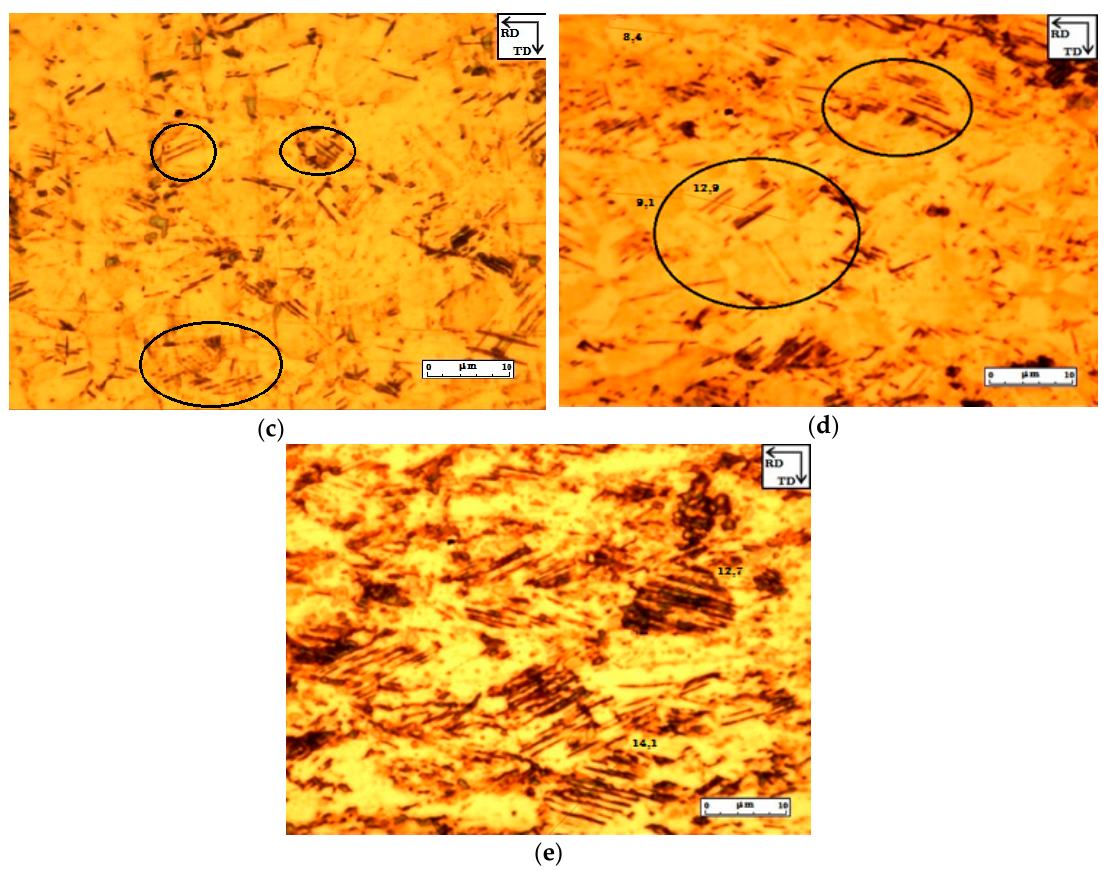
Figure 12. Optical microscopy. ( a ) Undeformed; ( b ) 10% of deformation; ( c ) 20% of deformation; ( d ) 30% of deformation; ( e ) deformed until maximum force was reached.